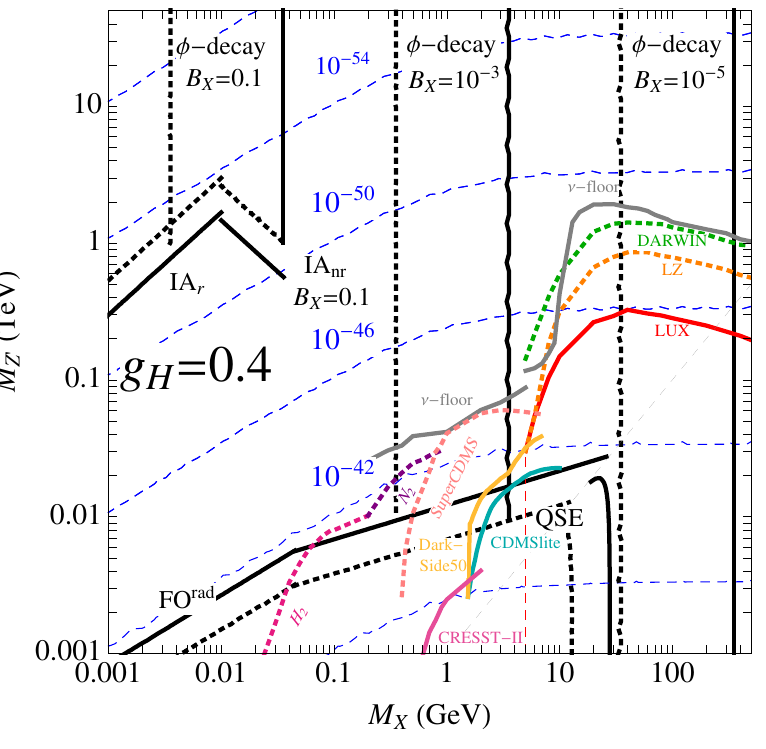
Figure 9. As in (cid:12)gure 8, with g